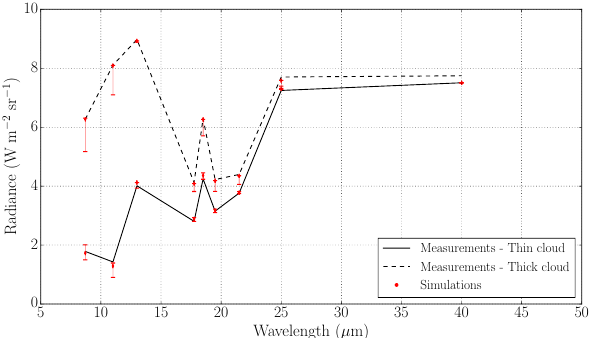
Figure 16. Time series of FIRR brightness temperatures for the 2 July 2015 experiment. Vertical dashed lines indicate when the four measurements shown in Fig. 17 were taken.